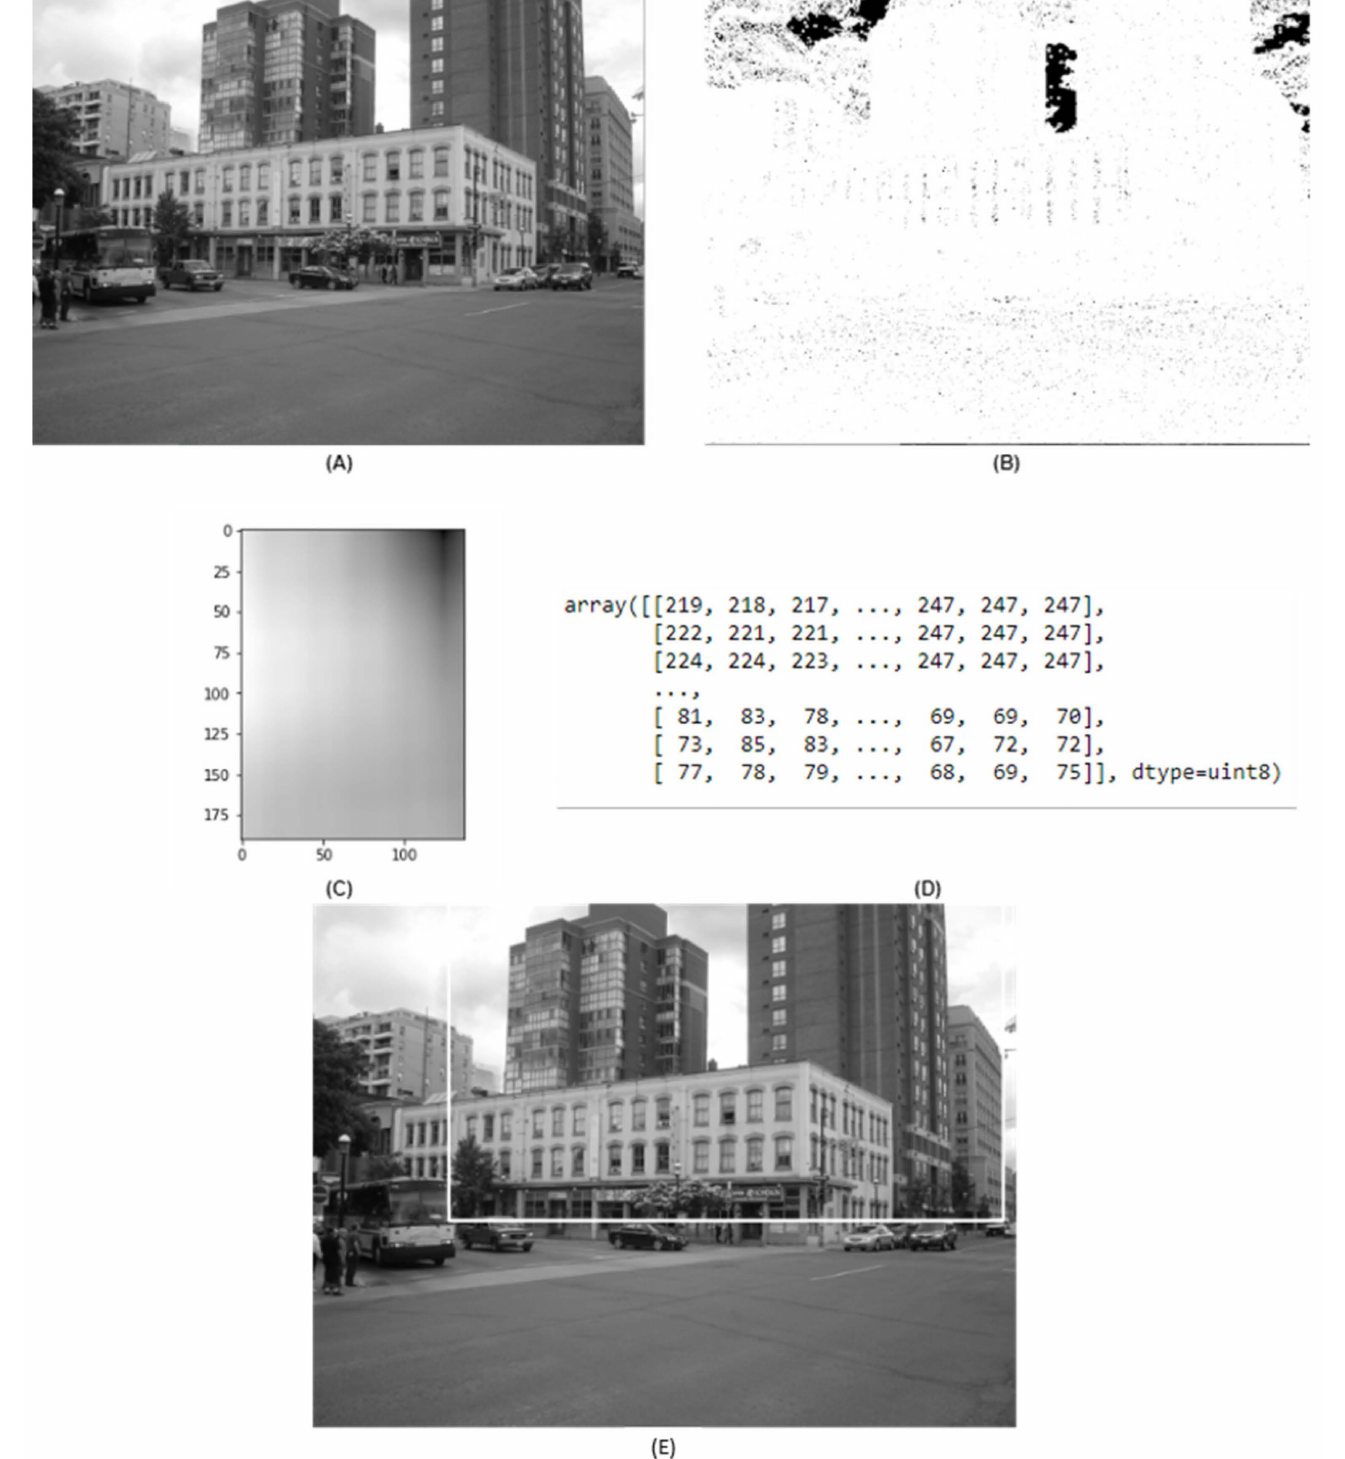
Figure 6. Simulation Results of the Proposed Blockchain-Aware Framework for Distributed Monitoring. ( A ) is the Input Image in the Form of Black and White, ( B ) is the Encoded Image, ( C ) is the Threshold, ( D ) is the Image Matrix, and ( E ) is the Output in the Form of Urban Land Surface